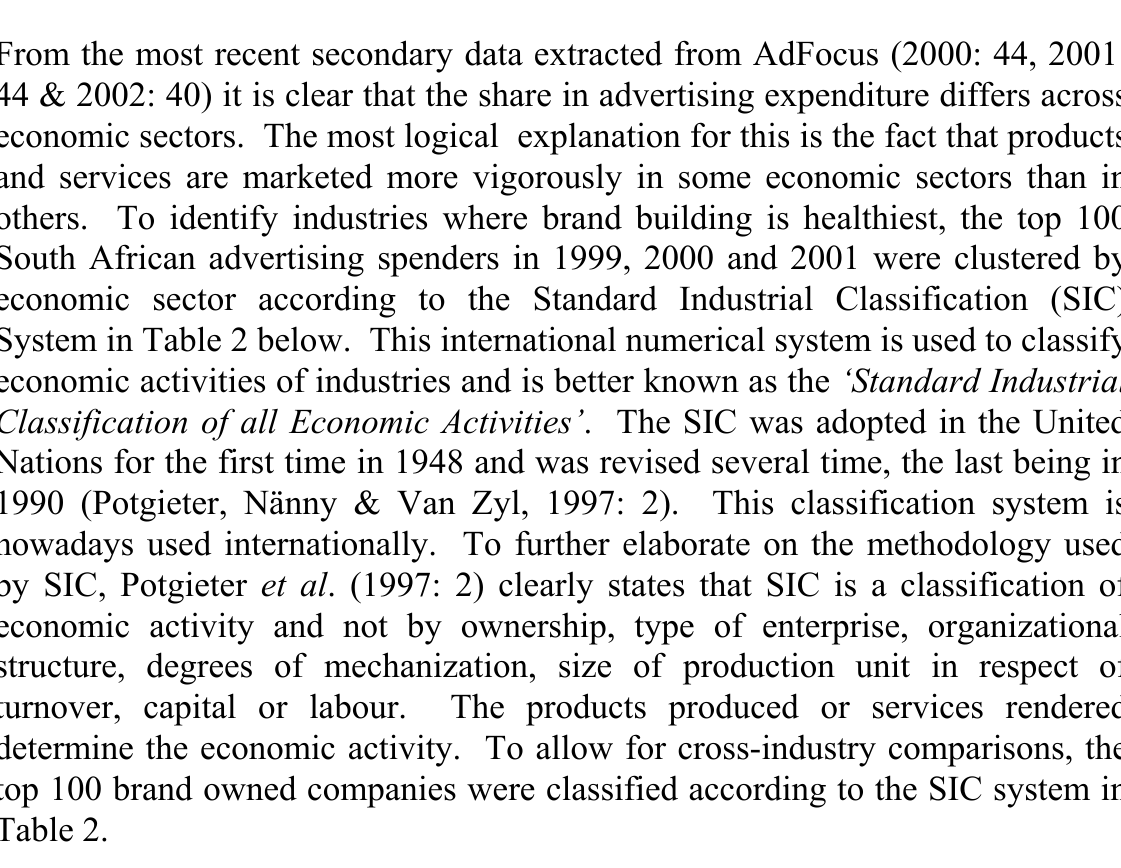
Magnitude of advertising expenditure of top 100 SA advertisers by economic sector*: 1999-2001 Advertising